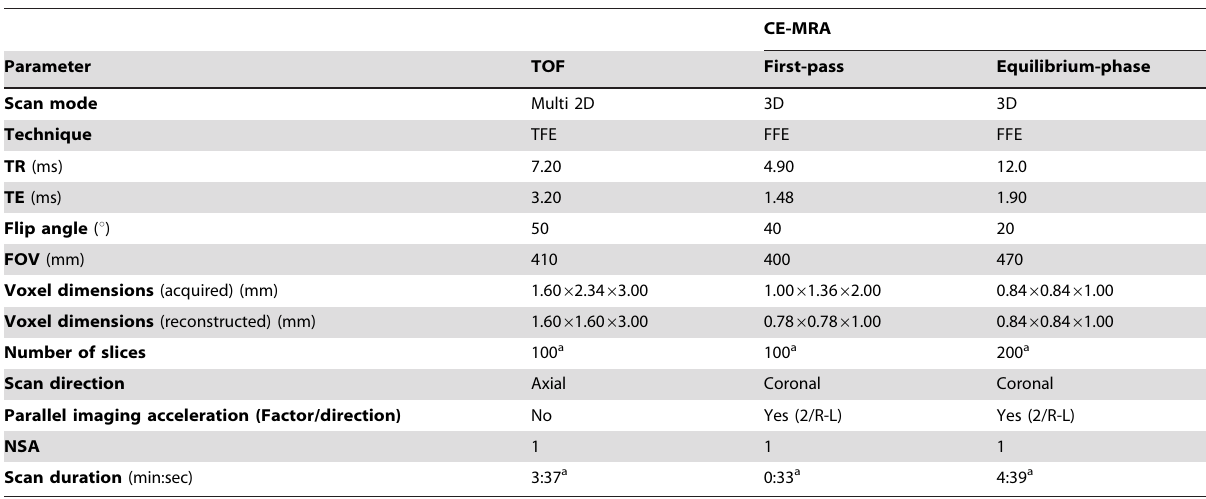
Table 1. Acquisition parameters for MRI